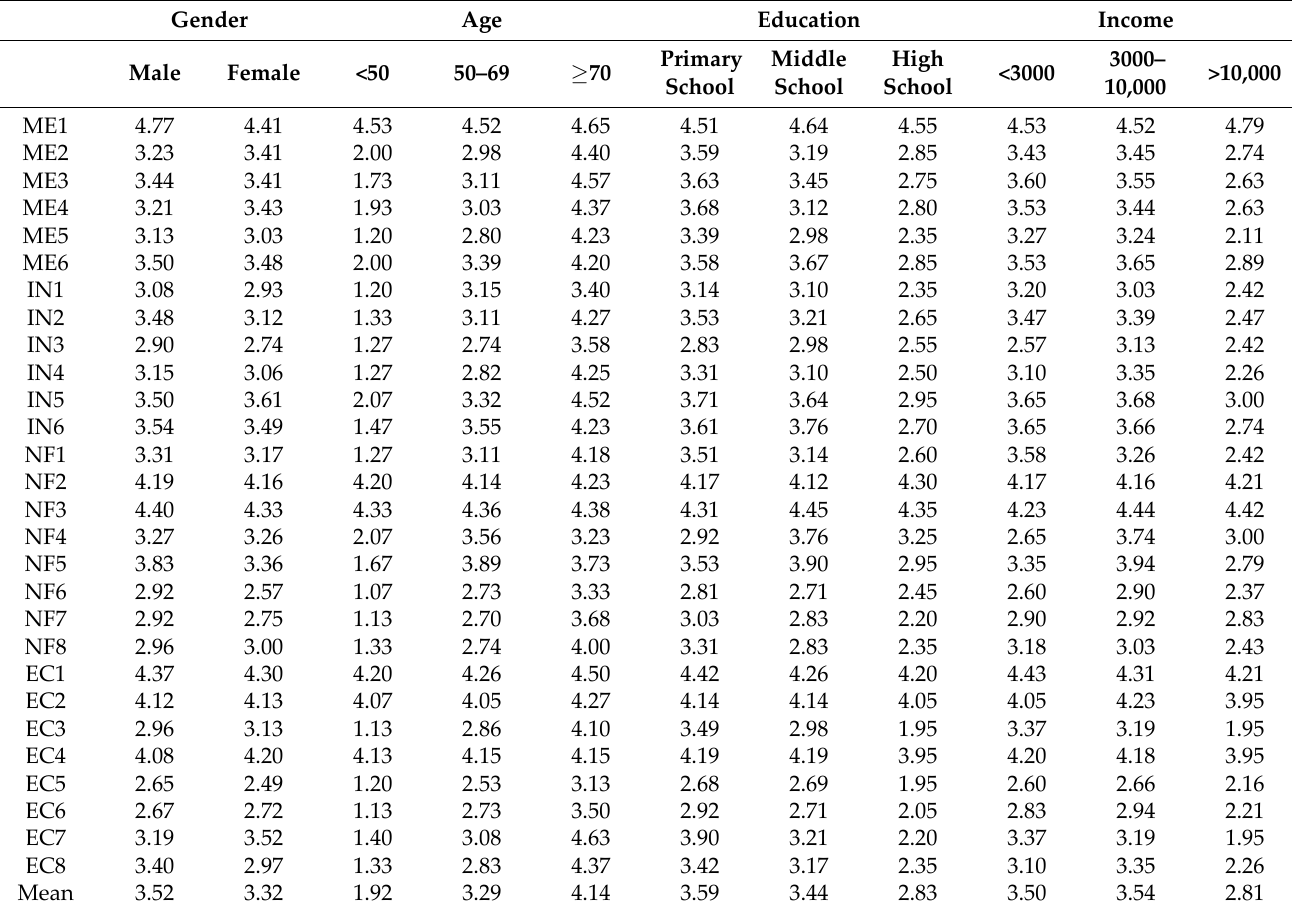
Table 3. Demographic characteristics of participants.